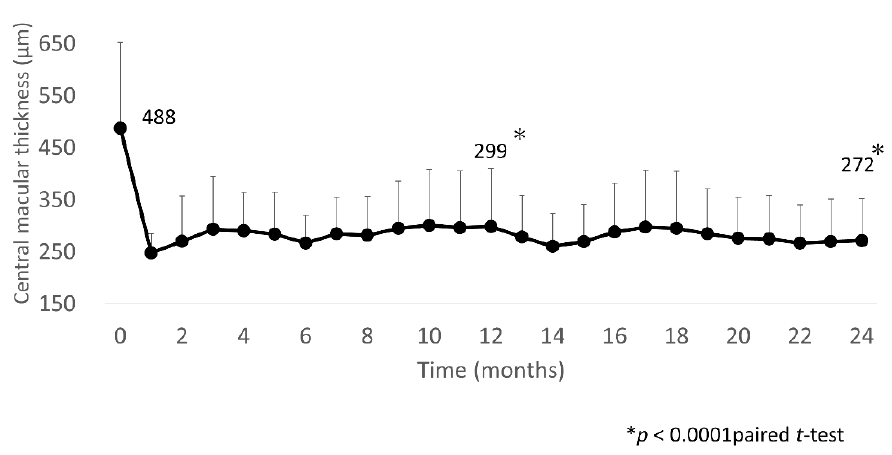
Figure 3. Mean CST over 24 months. Mean CST improved significantly at 1 month after IVA injection, with the improvement sustained through to 24 months. CST, central subfield thickness; IVA, intravitreal aflibercept.